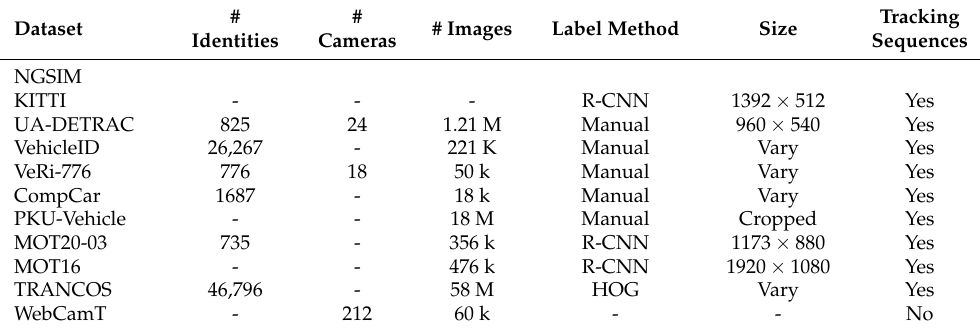
Table 6. Global overview of the public available databases for multi-object car ReID with trajectories. # Dataset